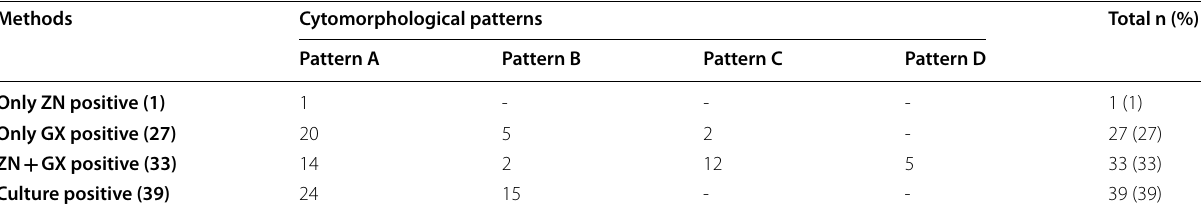
Table 3 Distribution of cases demonstrating positivity by ZN and/or GeneXpert MTB-RIF (GX) and/or culture according to cytomorphological patterns ( n =